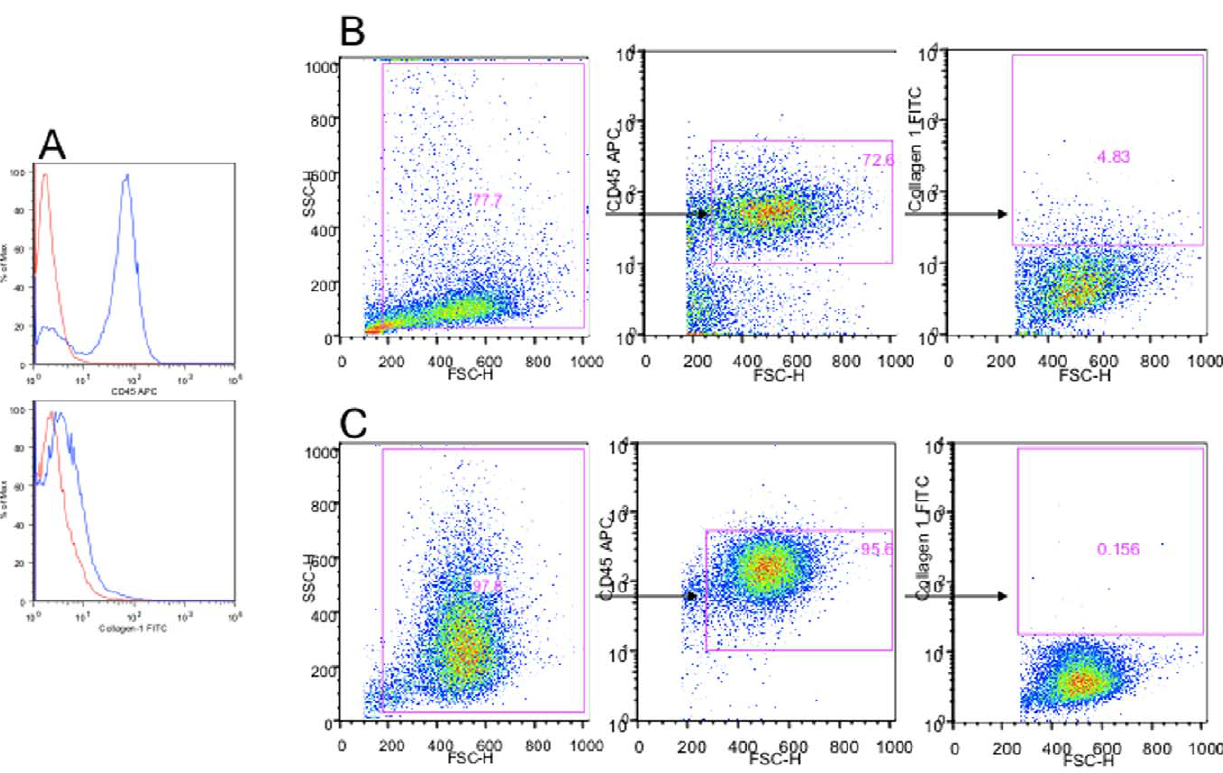
Figure 1. Representative flow cytometric analysis of bronchoalveolar lavage cells from a patient with idiopathic pulmonary fibrosis (IPF) and from a control patient. Flow cytometry was used to determine the percentage of fibrocytes. A) Cells were stained for CD45 and collagen 1, and analyzed by flow cytometry. Isotype control staining of cells is shown as red histograms and CD45 or collagen 1 as blue histograms. The negative threshold for all markers was set using the matched IgG isotype control. B) Sample analysis from one patient with IPF: In the left panel, forward scatter/side scatter (FSC/SSC) dot-plot, unstained cells were gated to exclude debris. In the middle panel, CD45 + cells were gated. In the right panel, CD45 + collagen 1 + cells were gated. C) Sample analysis from one control patient. In the left panel, forward scatter/side scatter (FSC/SSC) dot- plot, unstained cells were gated to exclude dead cells. In the middle panel, CD45 + cells were gated. In the right panel,CD45 + collagen 1 + cells were gated. The shape of the gate was chosen to account for autofluorescence. Fluorescein isothiocyanate, FITC; allophycocyanin, APC; forward scatter, FSC-H; side scatter, SSC-H. doi:10.1371/journal.pone.0053736.g001 P =0.43). The positivity of fibroblast culture was associated with [102–1033] vs 64 pg/ml [0–341] in negative cultures, but not with an increased concentration of CCL2 in BAL fluid at 262 pg/ml CXCL12.